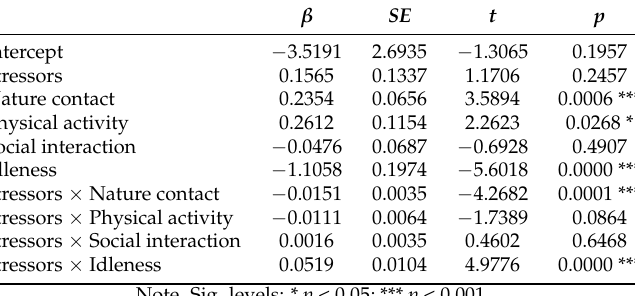
Table 4. Regression model predicting hair cortisol concentration (HCC) at T2 using stressors (SSCS) and attributes of recreational activities as predictors and HCC at T1 as a fixed intercept. R 2 =